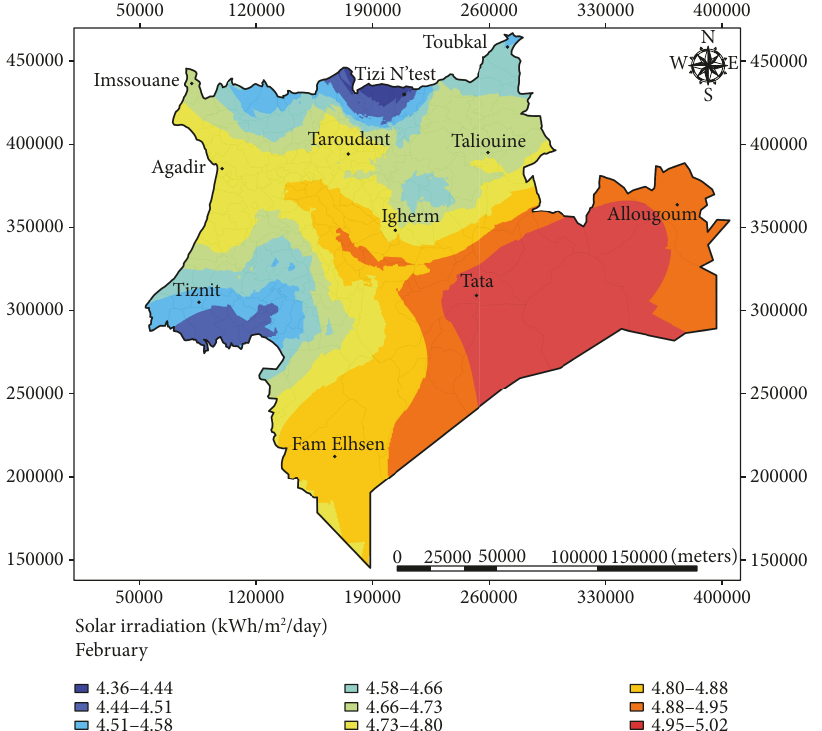
Figure 10: Solar energy potential map of the Souss-Massa area for the month of February as estimated by the ANN and designed with the Kriging interpolation